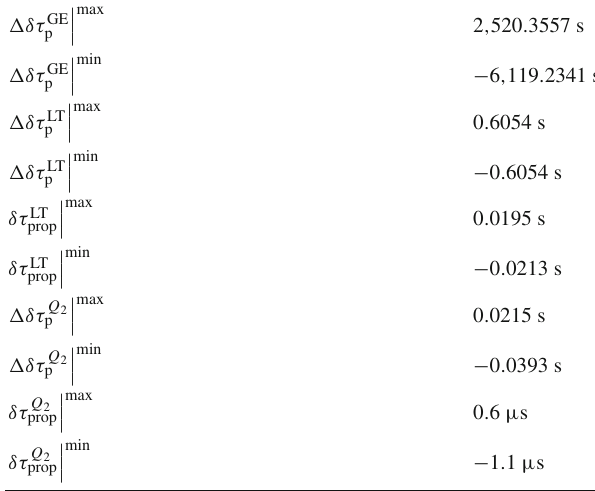
Table2 Maximumandminimumvaluesfortheorbitalandpropagation (cid:5) (cid:6) (cid:2)δτ , δτ timeshifts p prop over a full orbital revolution due tothe gravi- toelectric (GE), gravitomagnetic (LT) and quadrupole ( Q 2 ) effects for a hypothetical pulsar–Sgr A ∗ scenario. While the orbital time delay (cid:2)δτ p is cumulative over the revolutions, the propagation shift δτ prop vanishes overoneorbitalperiod.FortheputativepulsarorbitingtheSMBHinthe GC, the orbital configuration of the main sequence S2 star was adopted. The values of the system’s physical and orbital parameters correspond- ing to the quoted maxima and minima are not reported here: see the text for details. Only the angular momentum S • and the quadrupole Q • of the SMBH, playing the role of deflector d, were taken into account. The expected timing precision for a pulsar orbiting the galactic SMBH is about 100 µ s, or, perhaps, even 1–10 µ s